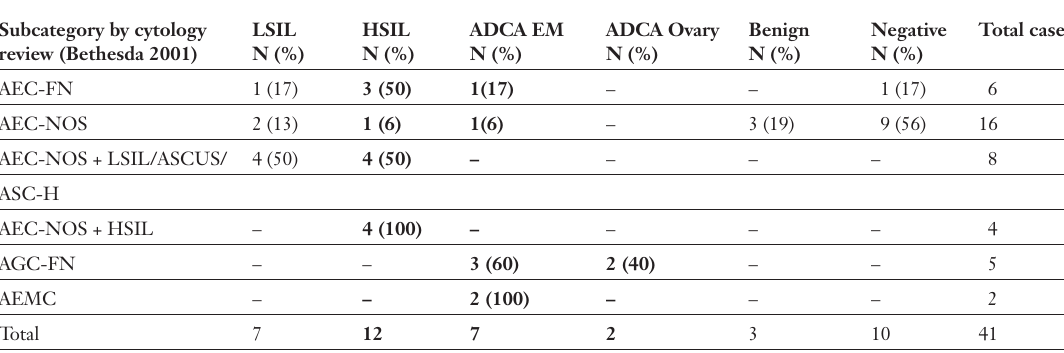
Clinically significant lesions (HSIL, ADCA) in AGC subcate- gories.